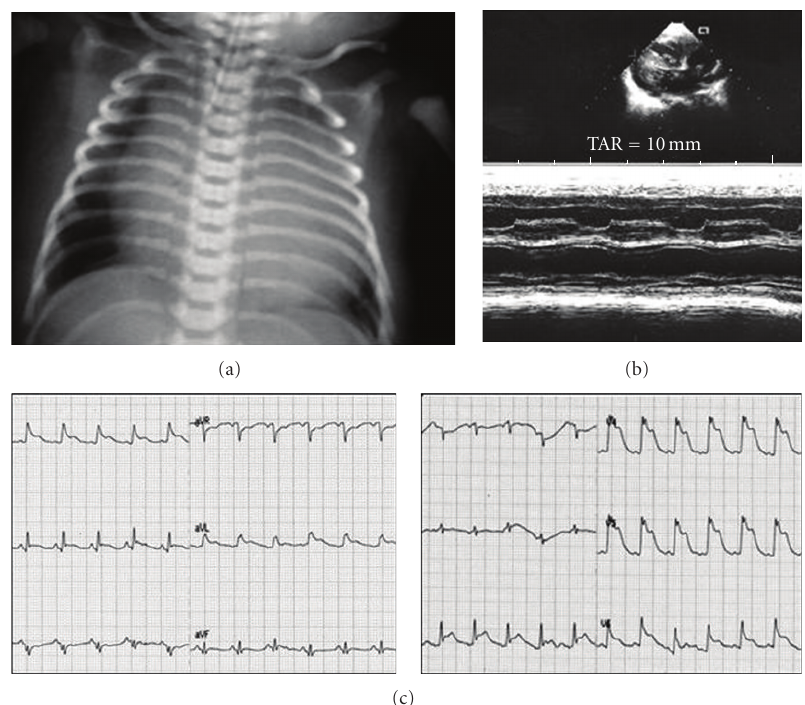
Figure 1: (a) Chest X-ray—marked cardiomegaly, (b) 2-D and M-mode echocardiography showing biventricular hypertrophy with left ventricular hypokinesis (c) ECG—signs of di ff use subendocardial ischemia-lesion.